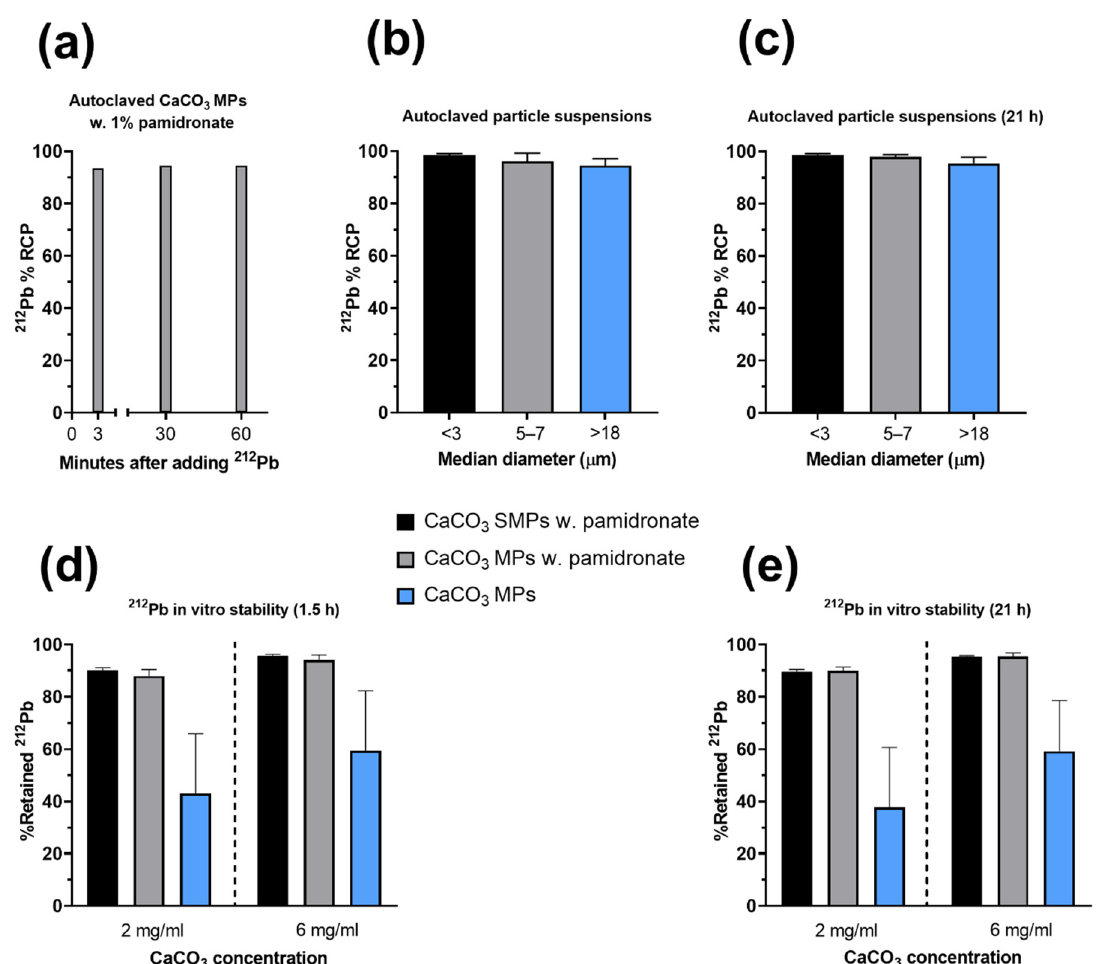
Figure 5. Radiochemical properties of various CaCO 3 particles in suspension after autoclaving and labeling with 212 Pb. The median diameters are based on laser diffraction measurements. ( a ) Percentage radiolabeling yield (same quantity as radiochemical purity (RCP)) as function of time after 212 Pb was added ( n = 2). ( b , c ) Percentage RCP as function of particle size or polymorphism (pamidronate-stabilized vaterite or recrystallized calcite) ( b ) on the same day as labeling and ( c ) after at least 21 h ( n = 4–6). ( d , e ) Retained 212 Pb on the particle types in (b, c) after 4 × or 12.5 × dilution and incubation in an isotonic solution with human serum albumin ( n = 4).